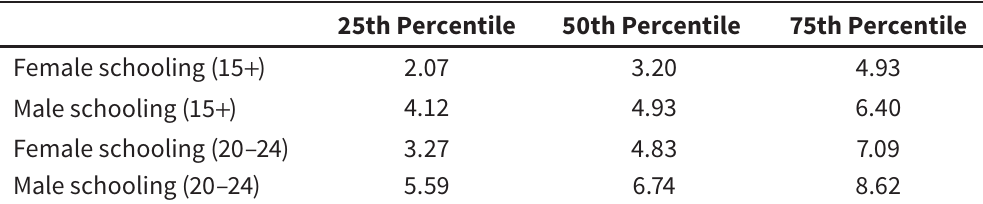
Schooling Characteristics in the Year of Widest Gender Gap for Countries Where Gender Gap Got Worse Before It Got